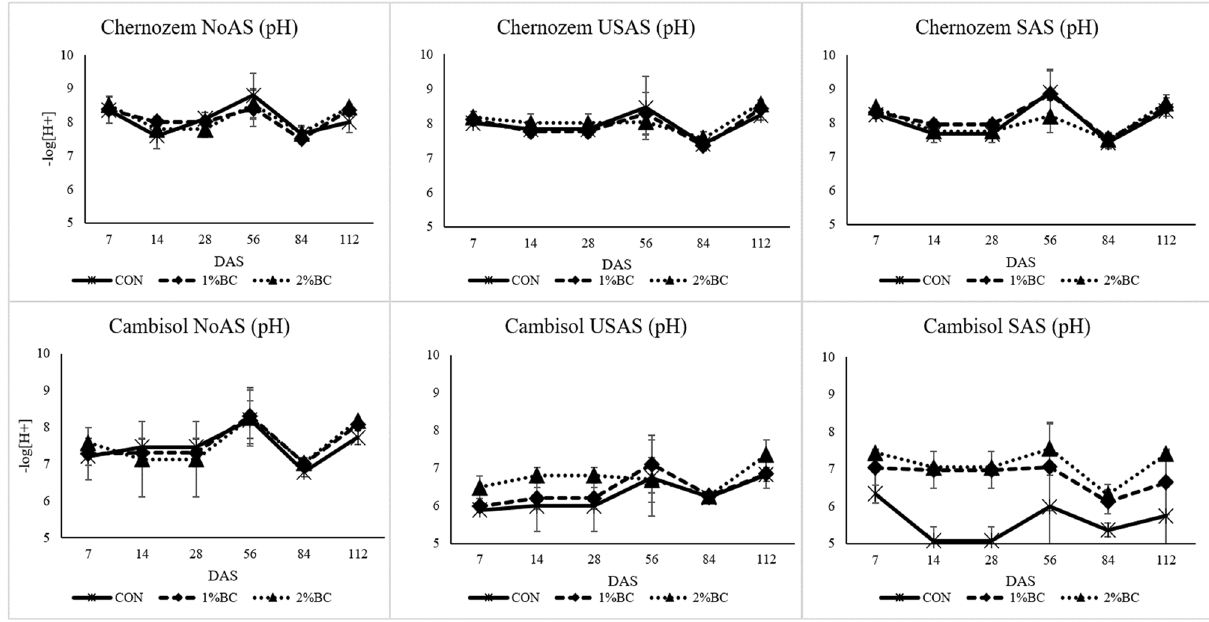
Figure 3. The effect of biochar, USAS (un-stabilized ammonium sulphate) and SAS (stabilized ammonium sulphate with DMPP) on the pH of soil solution, NoAS No ammonium sulphate, CON control, 1%BC 1% biochar, 2%BC 2% biochar, DAS day after